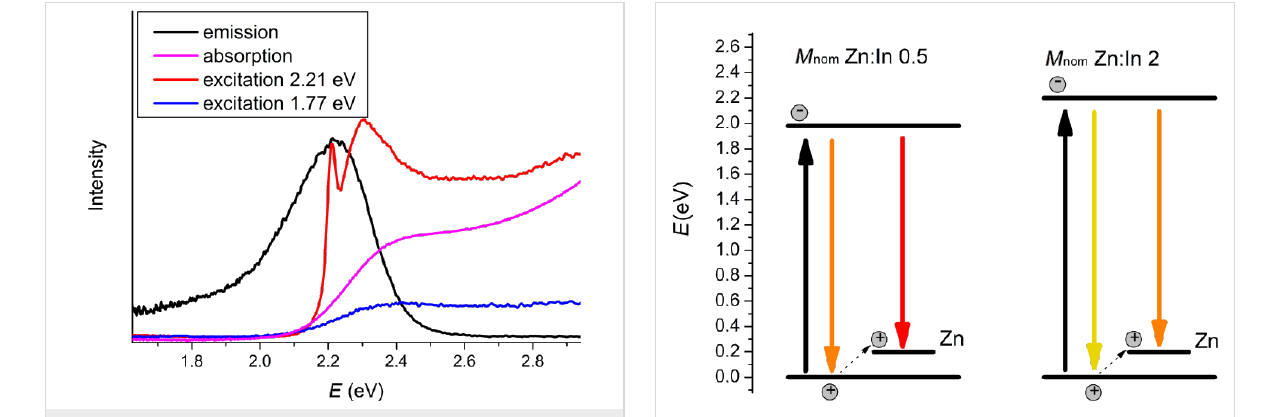
Figure 11: Comparison of typical excitation, PL and UV–vis absorp- tion spectra.